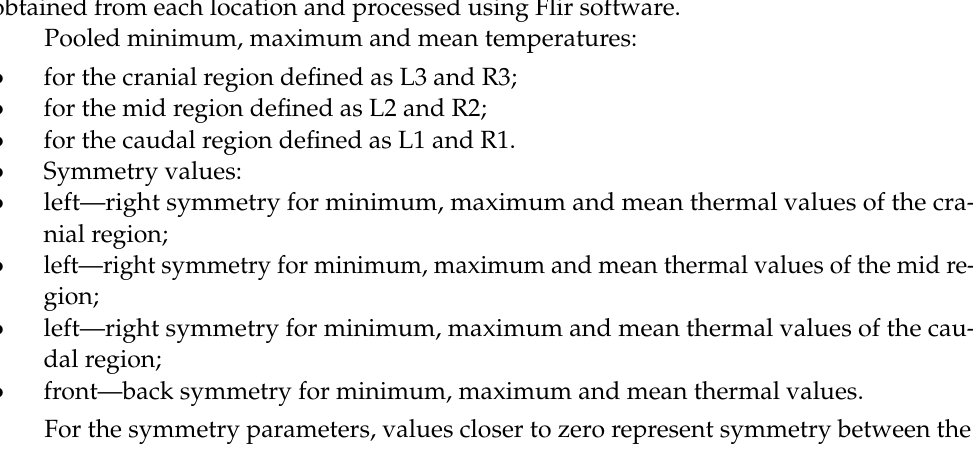
Figure 3. Illustrating the thermal grid reference used when quantifying thermal temperatures of the thoracic region ( left ) and ventral aspect of the saddle ( right ). A mask (grey area) was applied to areas of the grid which did not correspond to the horse’s back. Pooled minimum, maximum and mean temperatures (Figure 3):